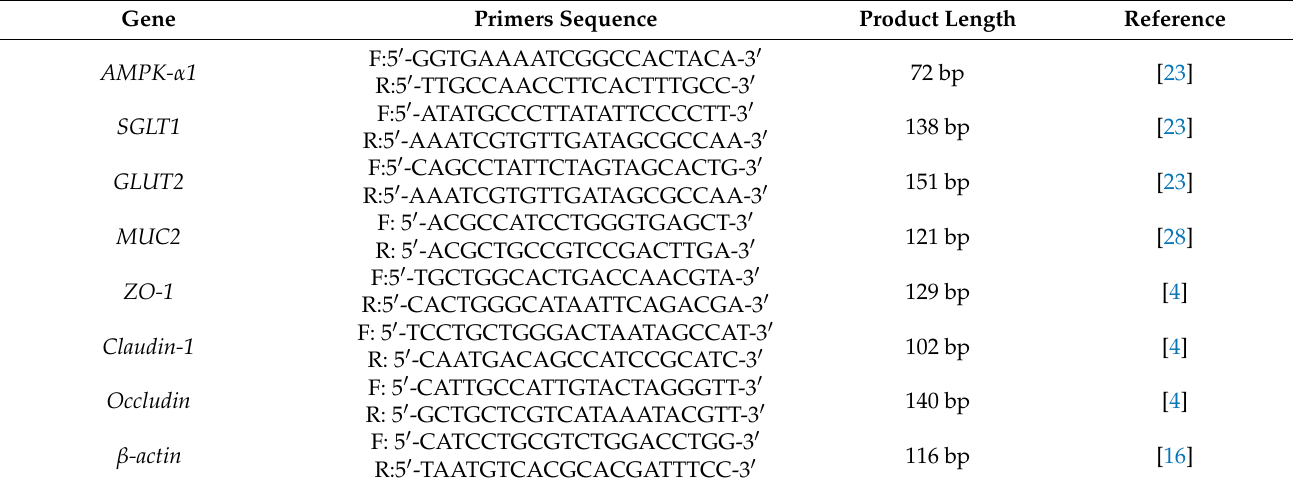
Table 2. Primers used for